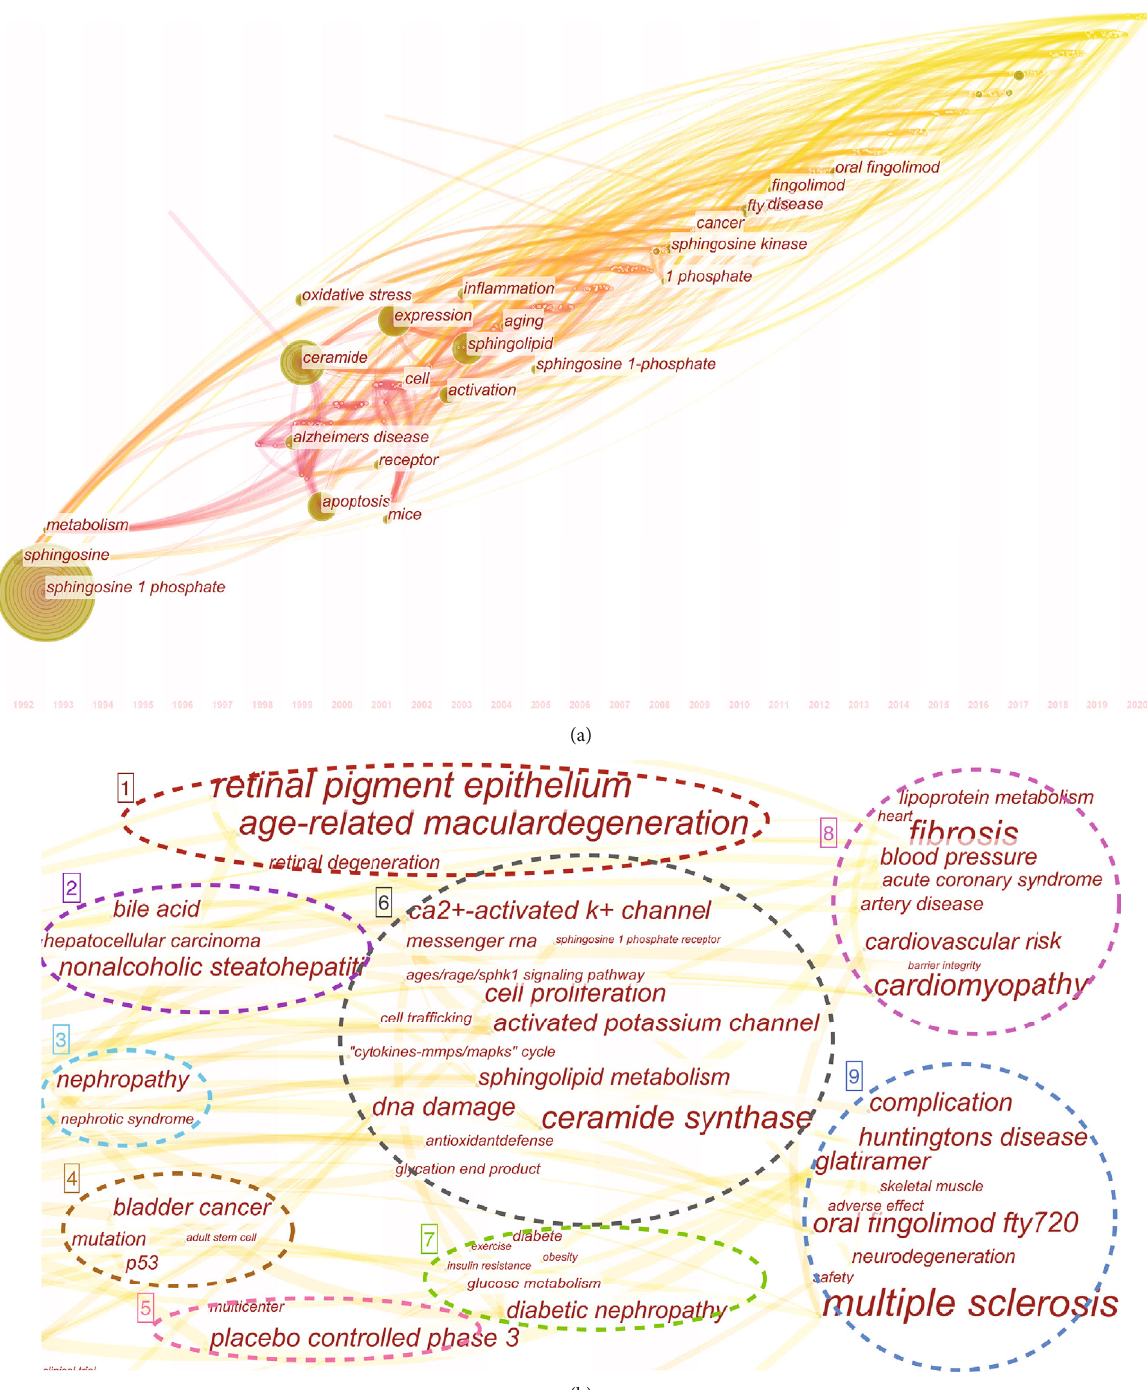
Figure 8: (a) Timeline view of common keywords. (b) Focused visualization of popular keywords used between 2016 and